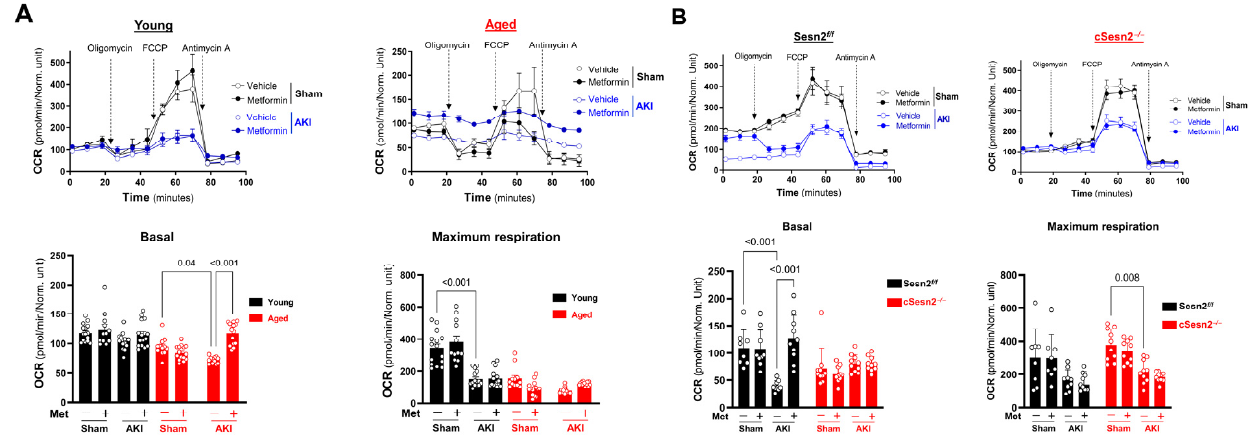
Figure 6. Oxygen consumption rate (OCR) of isolated cardiomyocytes from Seahorse X96 mito- chondrial stress test. Mitochondrial stress test profile including Basal and Maximum Respiration of ( A ) young vs. aged mice and ( B ) cSesn2 − / − vs. Sesn2 f/f mice. Means ± SEM; n = 8–15 per